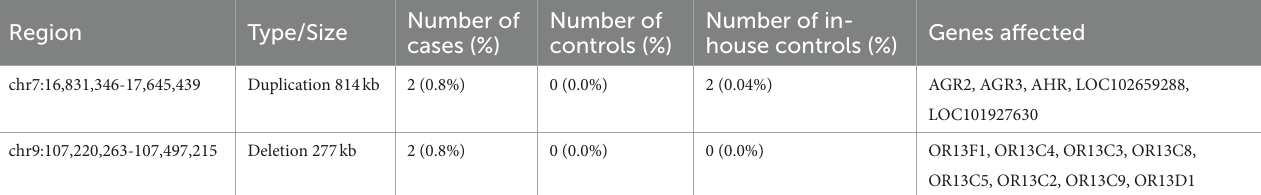
TABLE 3 Copy Number Variants present in more than one Saudi Schizophrenia case, zero matched controls, and rare in the American controls. Region